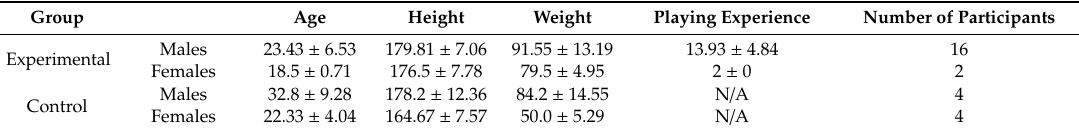
Table 1. Participant